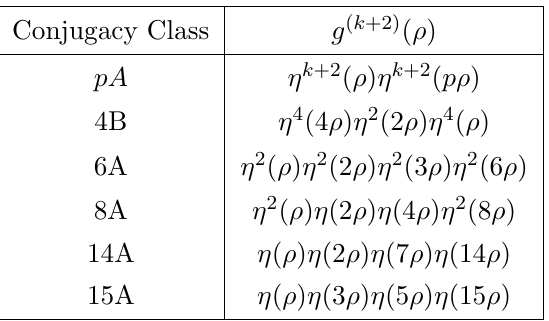
Table 3 . Factorization of ^(cid:8) k ( (cid:26); (cid:27); v ) as lim v ! 0, p 2 f 1 ; 2 ; 3 ; 5 ; 7 ; 11 g